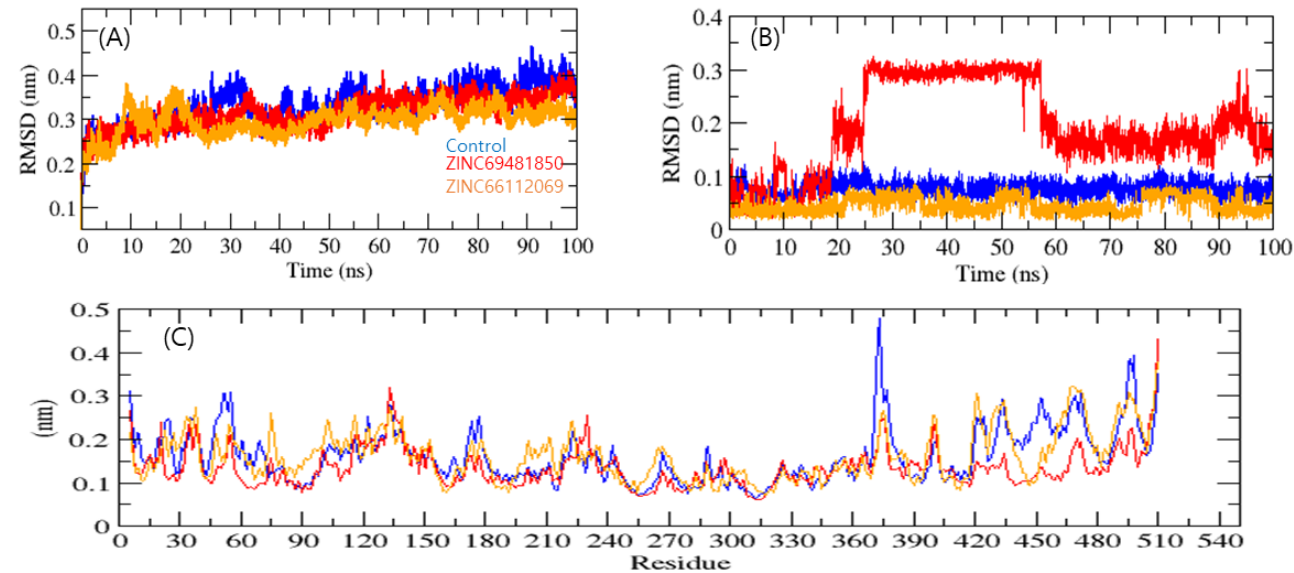
Figure 5. Complex structural stability studies. Protein backbone RMSD ( A ), Ligand RMSD plot ( B ), and RMSF of proteins ( C ). Control, ZINC69481850, and ZINC66112069 were shown in blue, red, and orange colors, respectively.